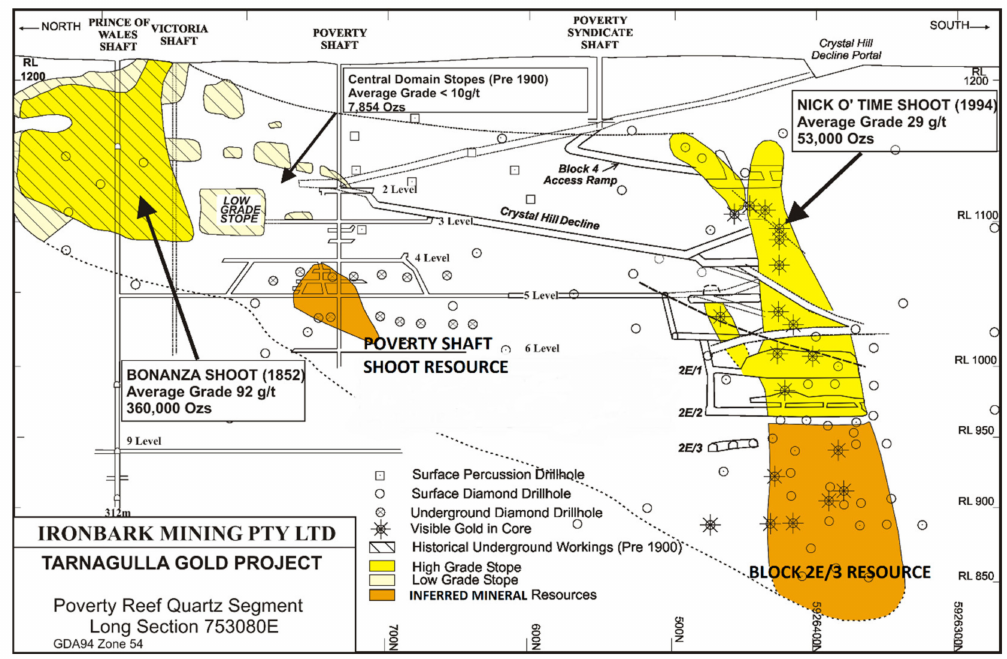
Figure 3. Bonanza and Nick O’Time shoots on the Poverty reef (after